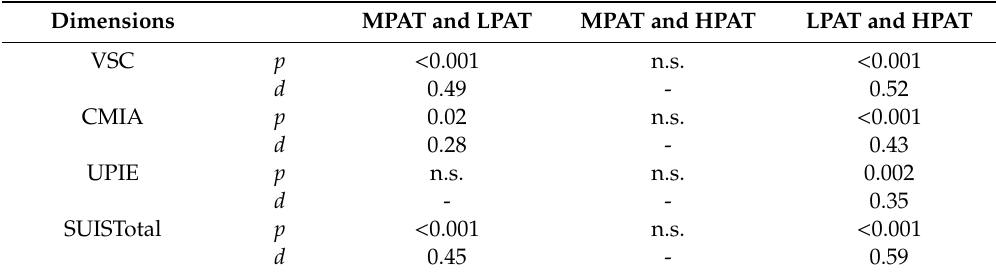
Table 2. Cohen’s d for post-hoc contrast between PAT profiles and dimensions of visual mental imagery. Dimensions MPAT and LPAT MPAT and HPAT LPAT and HPAT VSC p < 0.001 n.s. < 0.001 d 0.49 - 0.52 CMIA p 0.02 n.s. < 0.001 d 0.28 - 0.43 UPIE p n.s. n.s. 0.002 d - - 0.35 SUISTotal p < 0.001 n.s. < 0.001 d 0.45 -